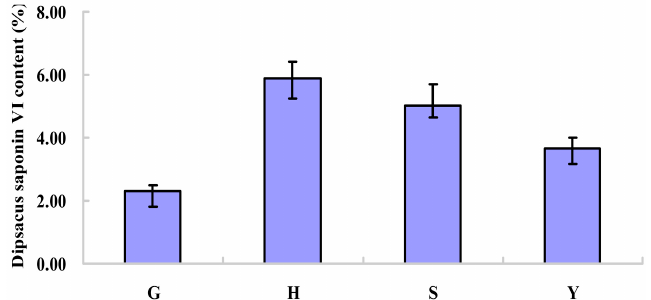
Figure 1. Contents of dipsacus saponin VI in D. asperoides of different habitats. G, H, S, and Y represent the dipsacus saponin VI content in D. asperoides from Guizhou, Hubei, Sichuan, and Yunnan, respectively. The % in the ordinate refers to the percentage of dry weight.